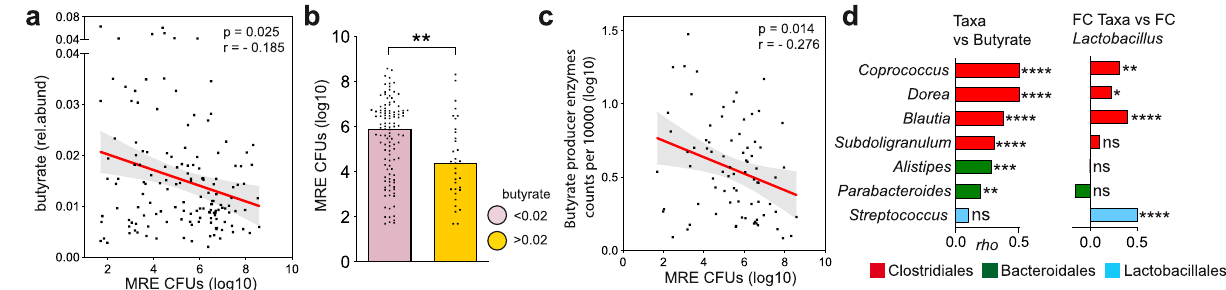
Fig. 6 | Similar interactions between Lactobacillus , Clostridiales genera, buty- rate and multidrug-resistant Enterobacteriaceae (MRE) levels are detected in hospitalized acute leukemia patients. a Negative correlation between butyrate andMRElevelswasdetectedinMRE-colonizedsamplescollectedfromhospitalized leukemia patients. Two-sided Spearman correlation test, p =0.025, ρ = − 0.185, N =147samples.Rel.abund:relativeabundance.CFUscolony-formingunits. b MRE- colonized samples collected from hospitalized patients that had higher levels of butyratehadsigni fi cantlylowerMRElevels,ascomparedtosamplesthathadlower butyrate levels. Two-sided Mann – Whitney test, ** p =0.005; N =114 and 33 samples per group. Barsrepresent the median. c Spearmancorrelation analysis of the fecal levelsof enzymes involvedinproduction ofbutyrateand the fecal levelsof MREin MRE-colonized samples. Only samples containing detectable levels of enzymes